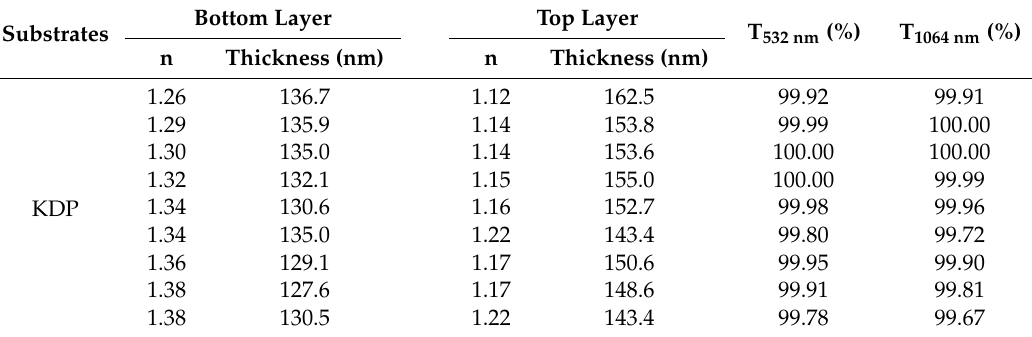
Table 1. Optimized design of a dual-layer coating system for double-wavelength